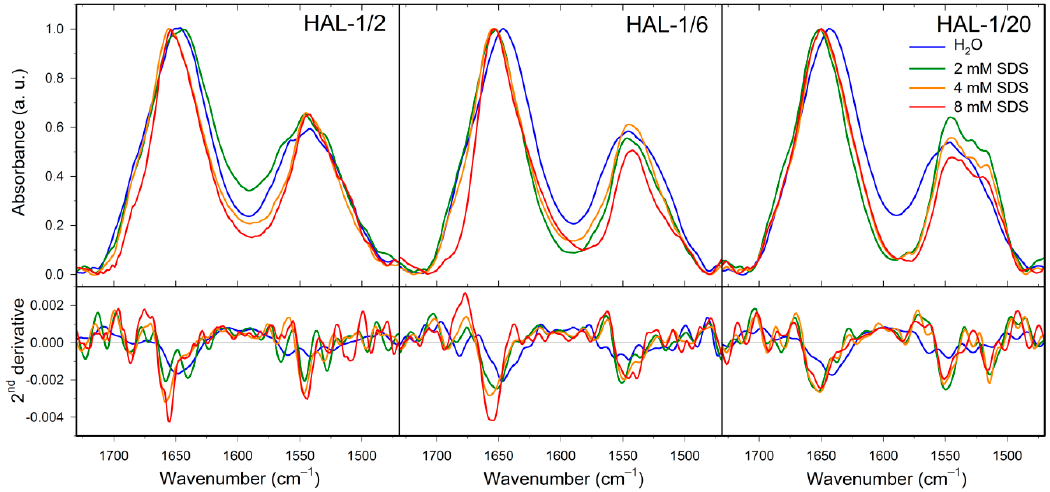
Figure 7. IR spectra ( top ) and their second derivatives ( bottom ) of HAL-1/2, HAL-1/6 and HAL-1/20 (10 mg/mL) in the presence of SDS (0, 2, 4, and 8 mM).